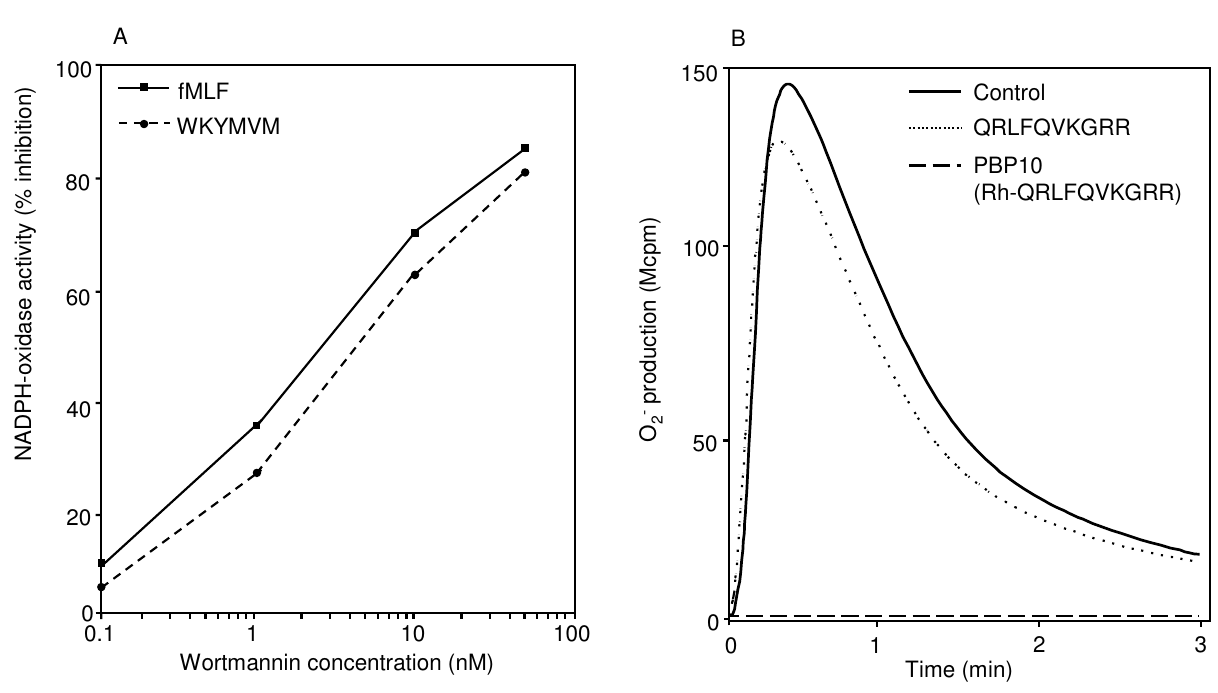
Figure 2 Effect of different inhibitors on the neutrophil NADPH-oxidase activity. (A) Neutrophils were incubated with differ- ent concentrations of the PI3K specific inhibitor Wortmannin at 37°C for 30 minutes followed by stimulation with fMLF (100 nM) or WKYMVM (100 nM). A representative experiment is shown. (B) Neutrophils were incubated with the cell impermea-